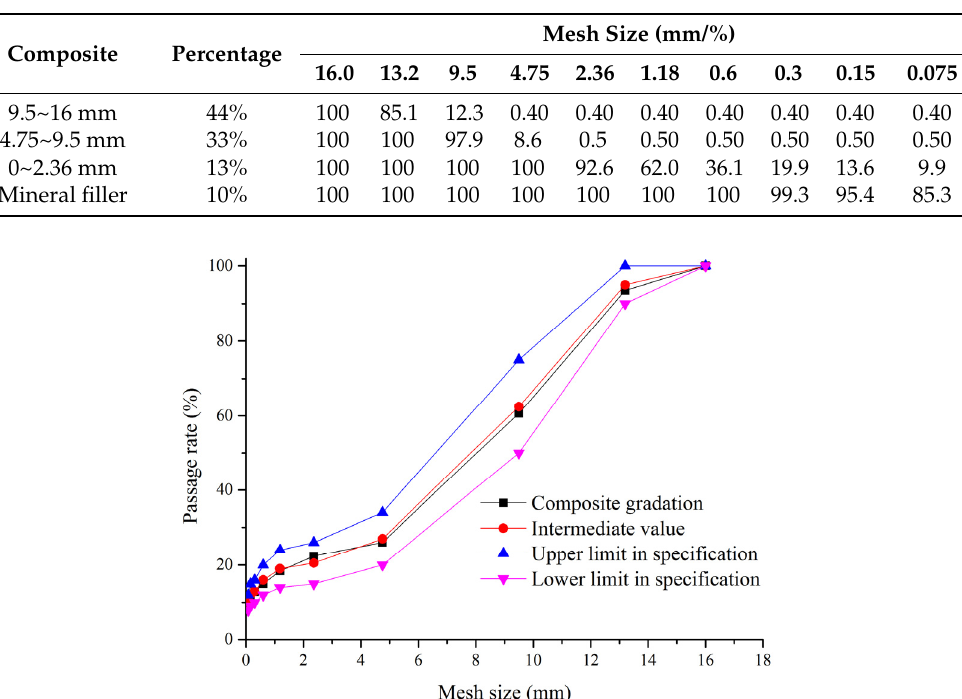
Table 6. Gradation of SMA-13 asphalt mixture.